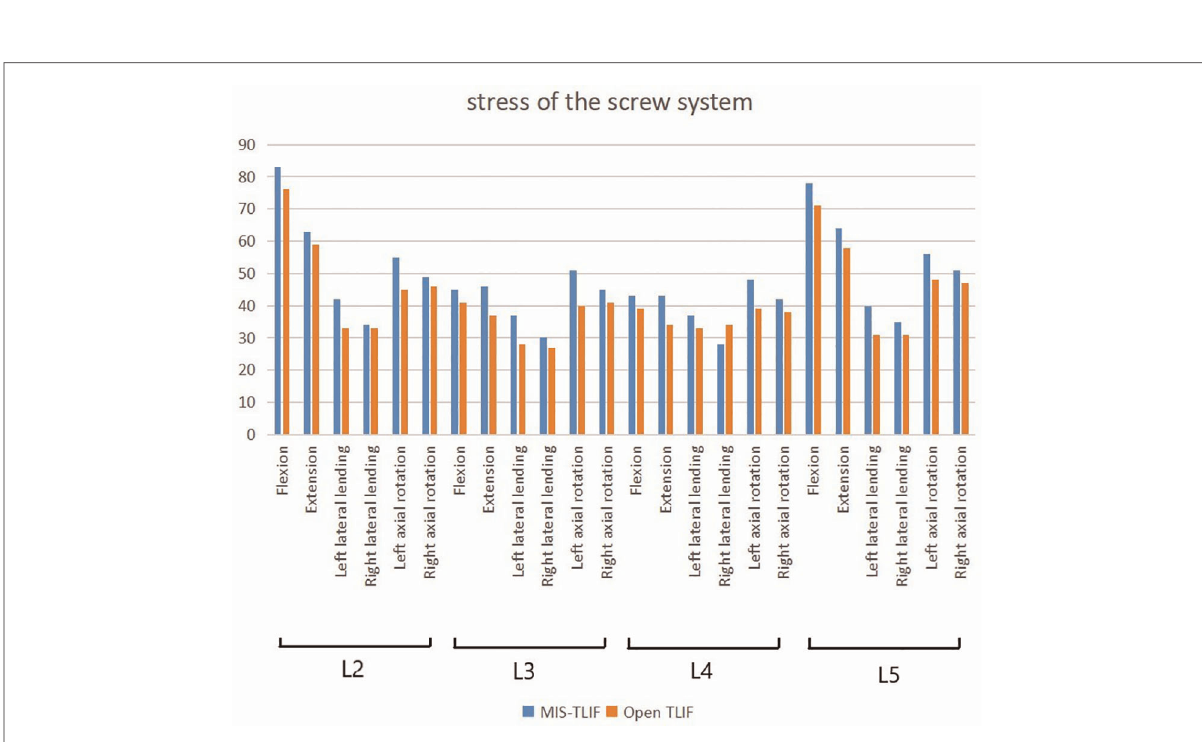
FIGURE 6 The stress value of screw systems in two kinds of 3-level model under different